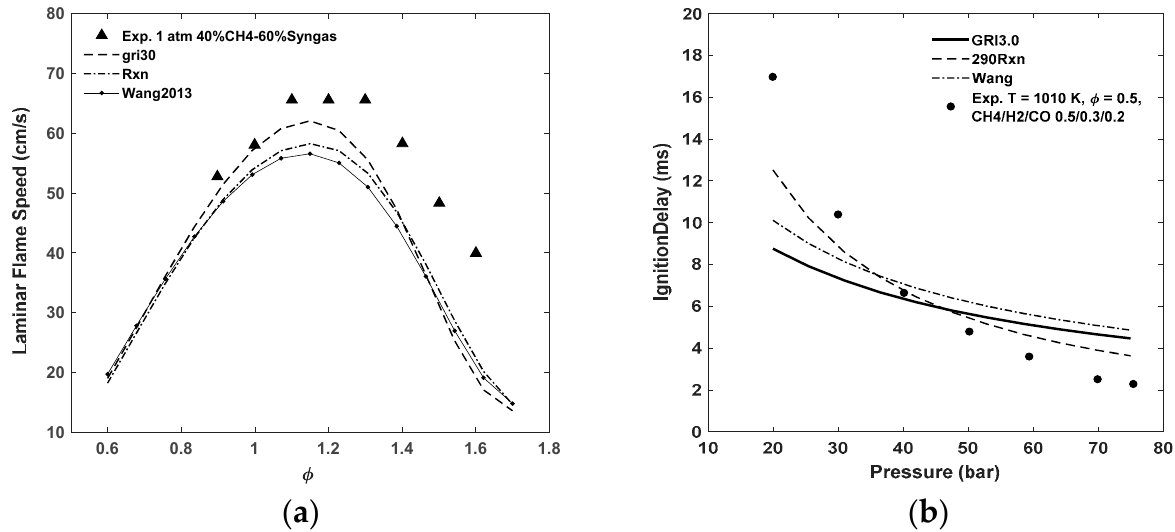
Figure 10. ( a ) Comparison of laminar flame speeds of CH 4 /H 2 /CO blend at p = 1 atm with experimental data [43]; ( b ) Ignition delay times versus pressure for CH 4 /H 2 /CO blend at different pressures using GRI 3.0, 290Rxn, and Wang mechanisms.